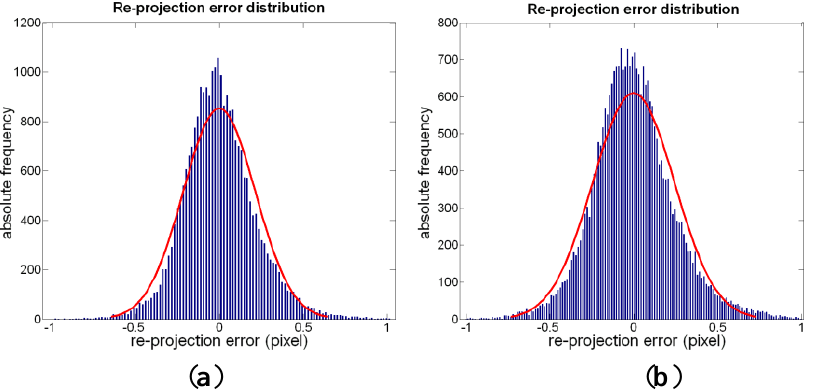
Figure 8. Distribution of the re-projection error (in pixels) in air and clear water (RGB images); ( a ) Air; ( b ) Water.